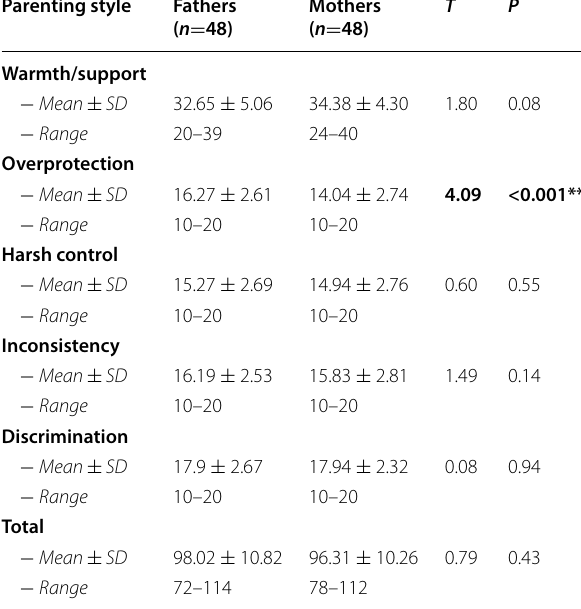
**highly significant